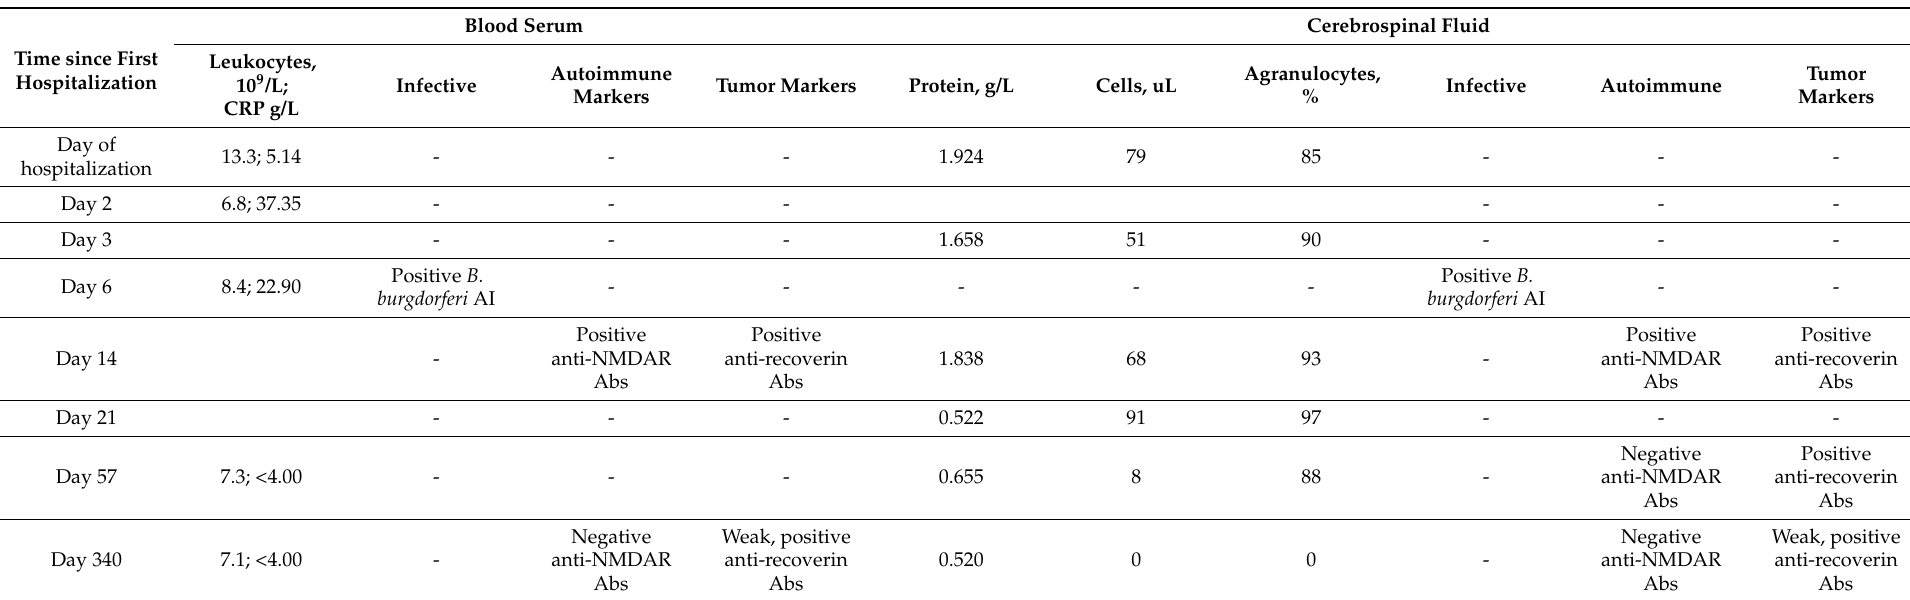
Table 1. Laboratory analysis.